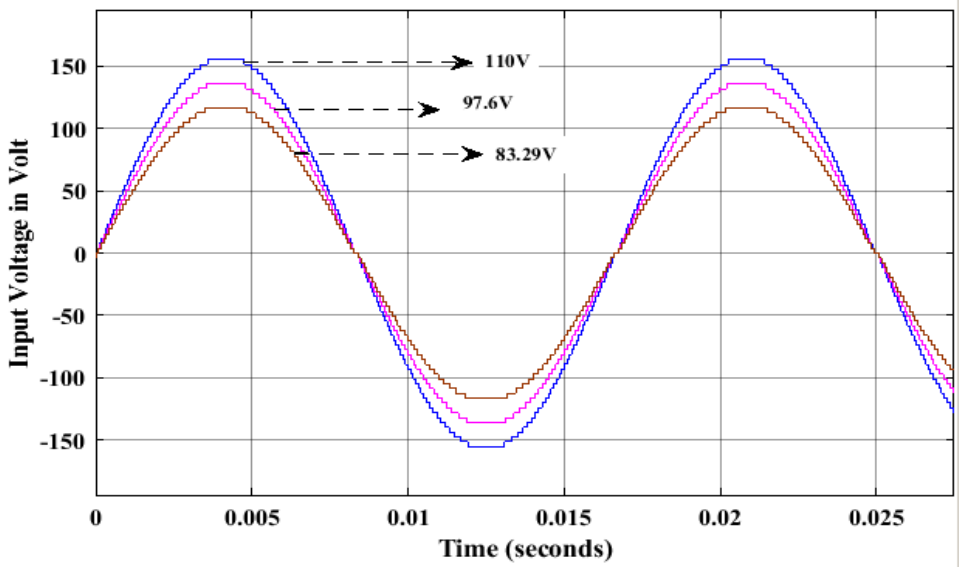
Figure 14. Different Output voltages of a SLMLI.